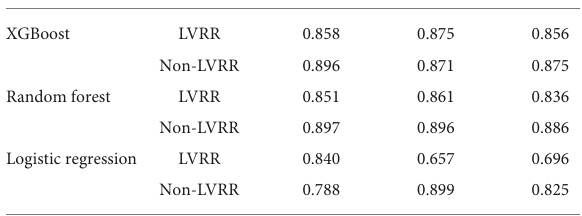
TABLE 2 Model performance comparison.